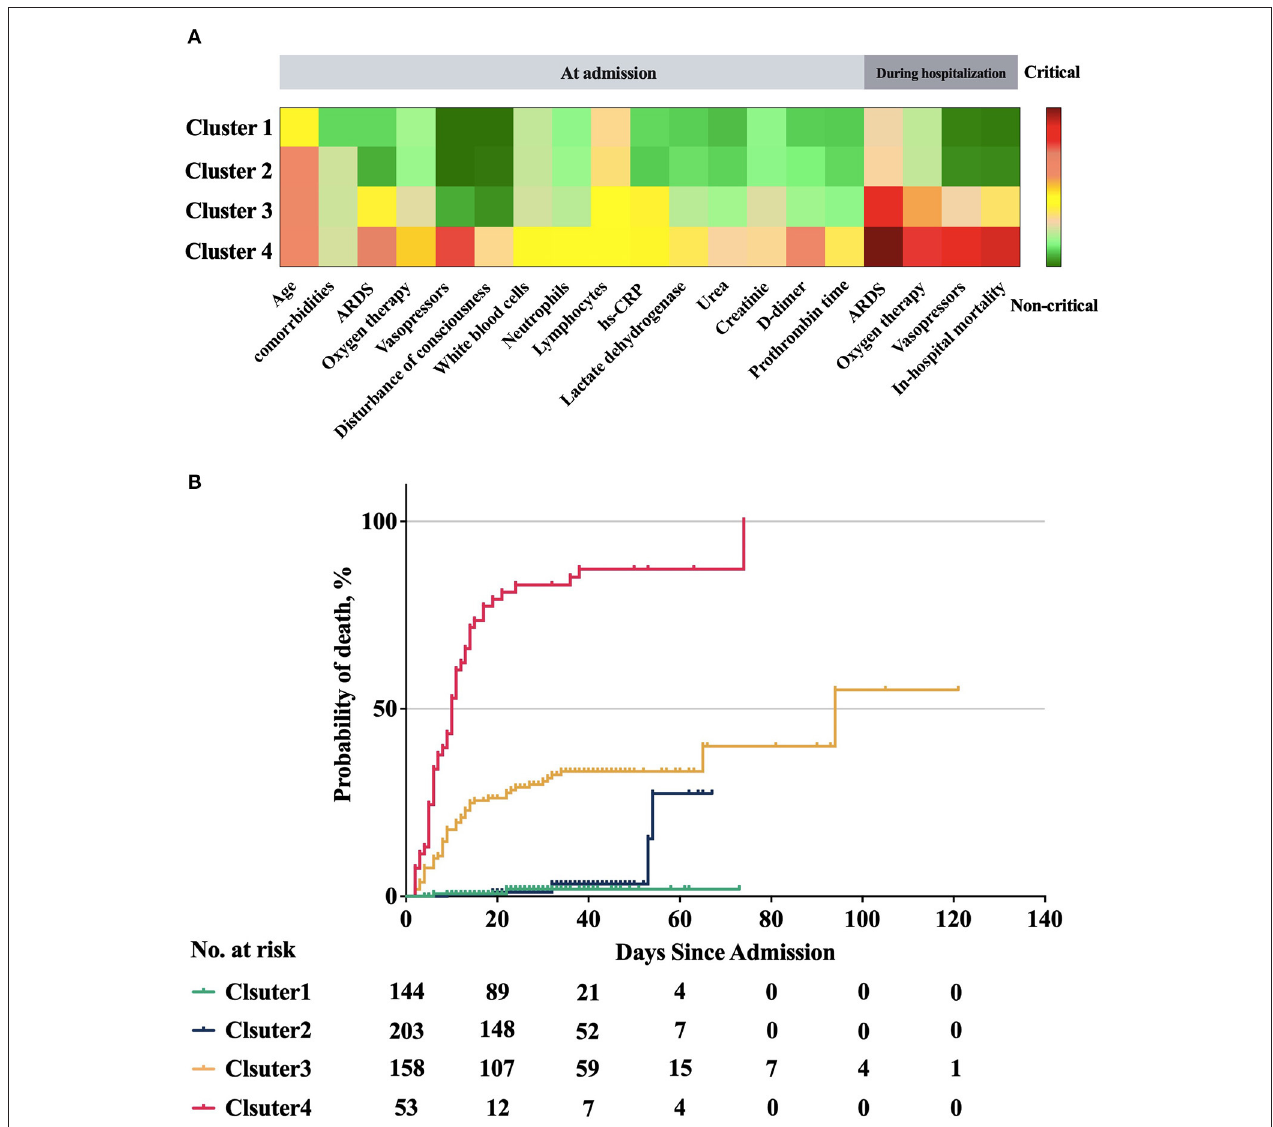
FIGURE 5 | Clinical characteristics and probability of death of the four clusters. Clusters 1 and 2 were non-critical cases from admission to discharge and they showed lower probability of death. Cluster 3 had significant higher in hospital mortality and probability of death than clusters 1 and 2, but lower than that in cluster 4. Cluster 4 had the highest in hospital mortality and probability of death, and there were significant differences with the other three clusters. (A) Clinical characteristics of four clusters. Some of the significant clinical features are plotted for each cluster. The features are displayed by color-coded heatmap with normalized values. (B) Comparison of probability of death between four clusters. There was statistically significant difference in the survival distribution between any two groups ( P < 0.001), except that there was no statistically significant difference in the survival distribution of cluster 1 and cluster 2 (Log-Rank test, P = 0.512 >